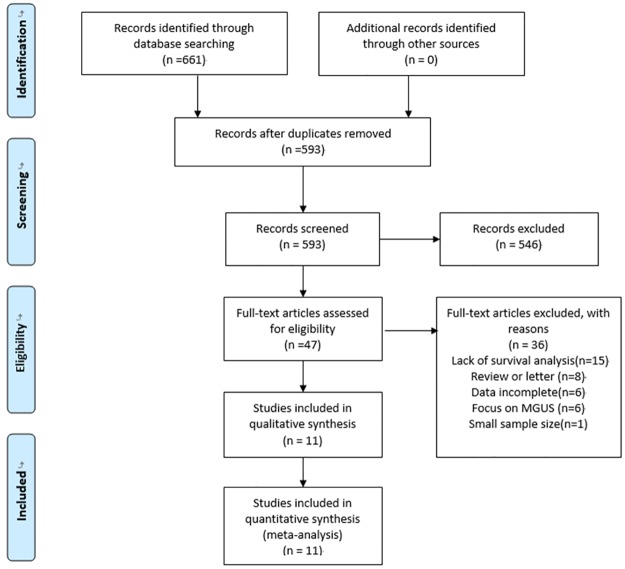
Flow diagram showing the selection process for the including studies.